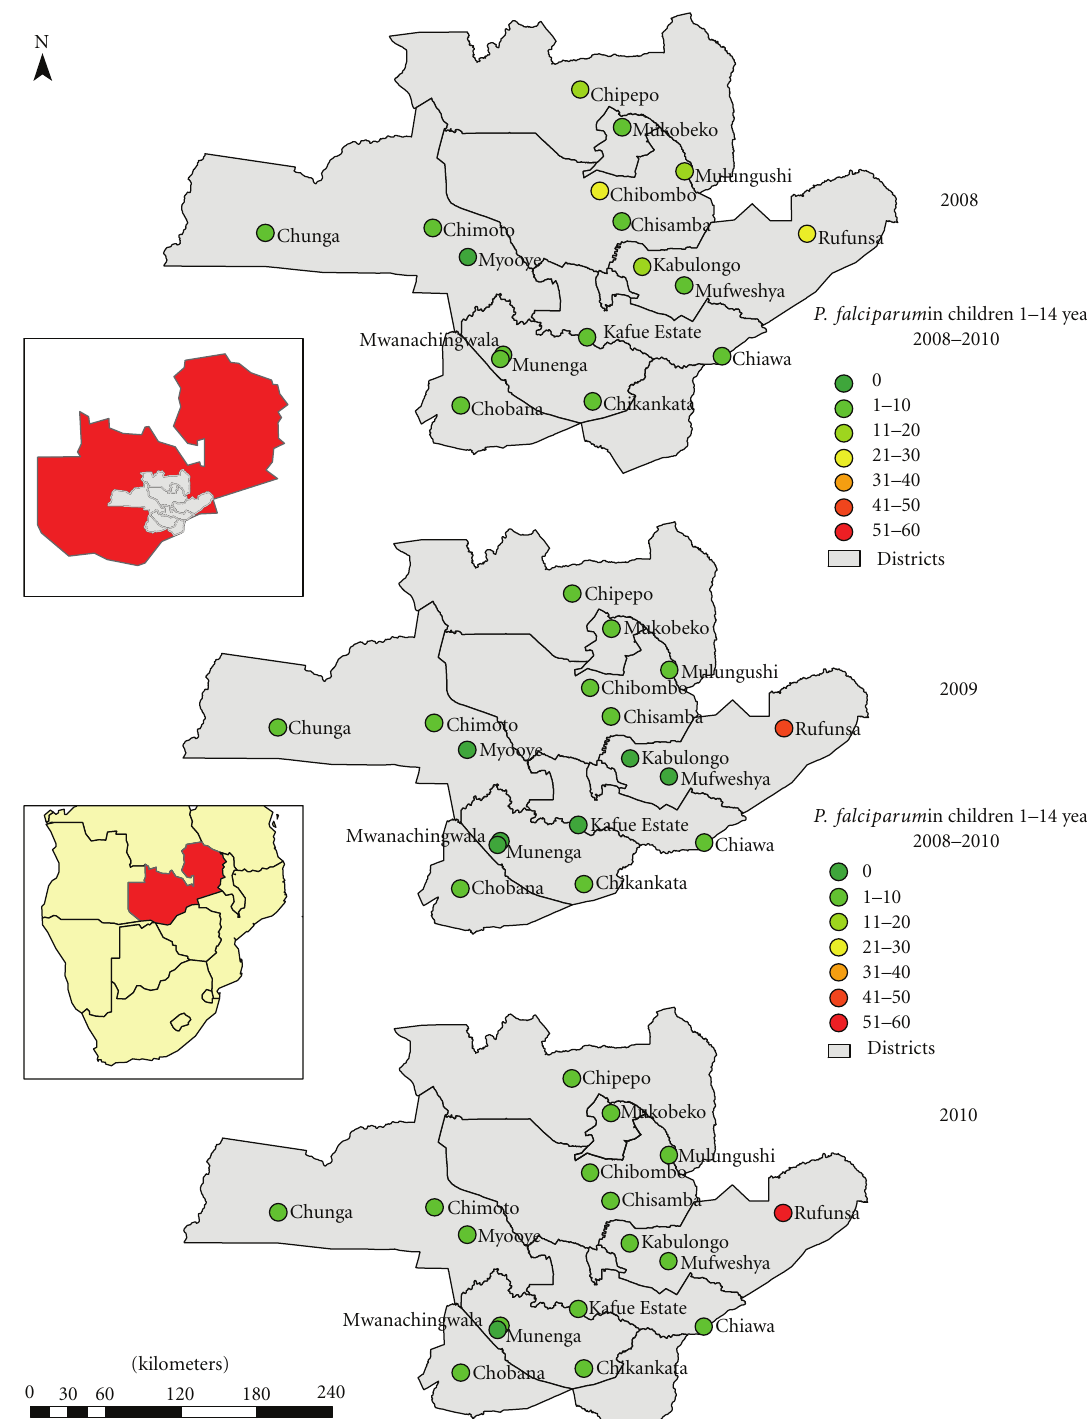
Figure 2: P. falciparum malaria parasite prevalence in children 1 to < 15 years in monitoring sentinel sites from 2008 to 2010 surveys.